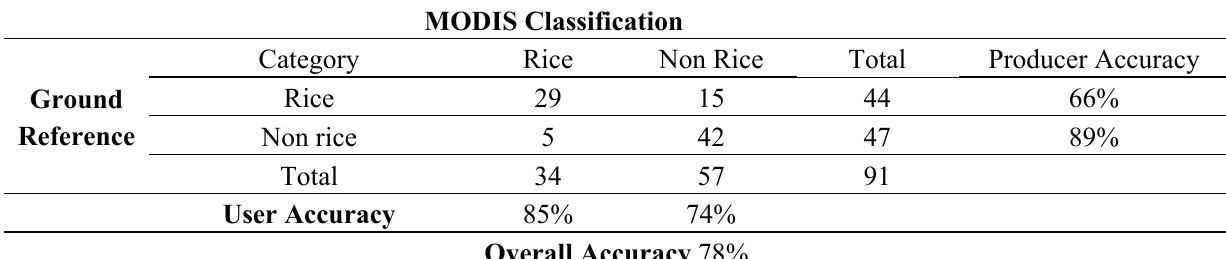
Table 3. Accuracy assessment using field surveyed